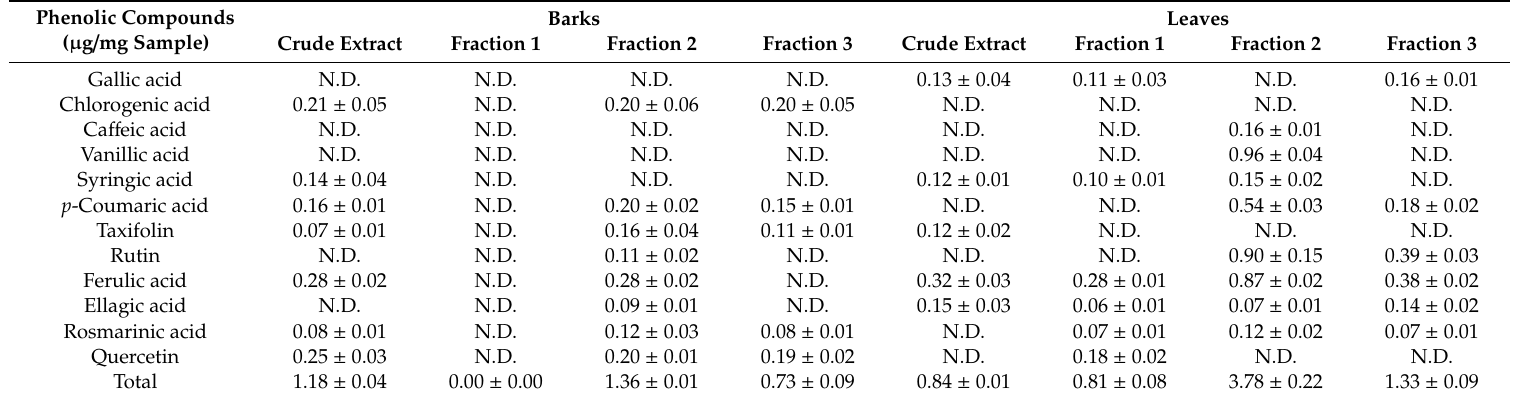
Table 2. Phenolic profile of J. paniculata ( n = 2; N.D. = not detected).